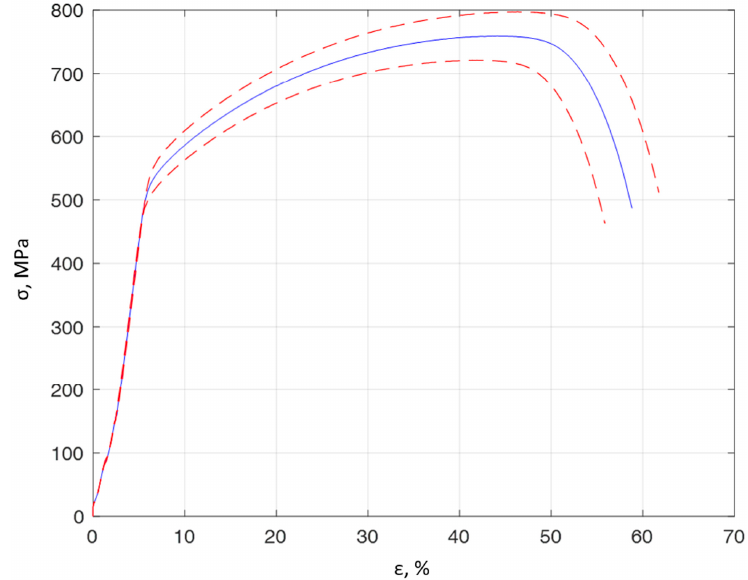
Figure 4. The average tensile curve for 0H18N9 steel for 6 specimens (solid line blue color) with a standard deviation of 5% (dashed lines red color).